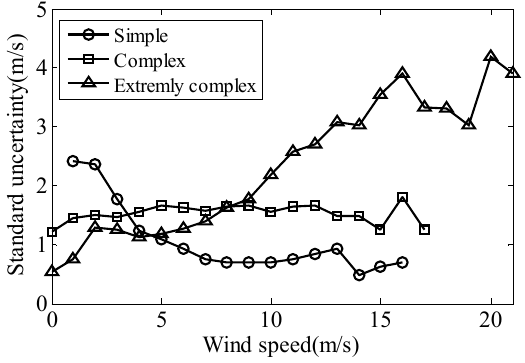
Figure 4. Standard uncertainties of three operational condition classes.